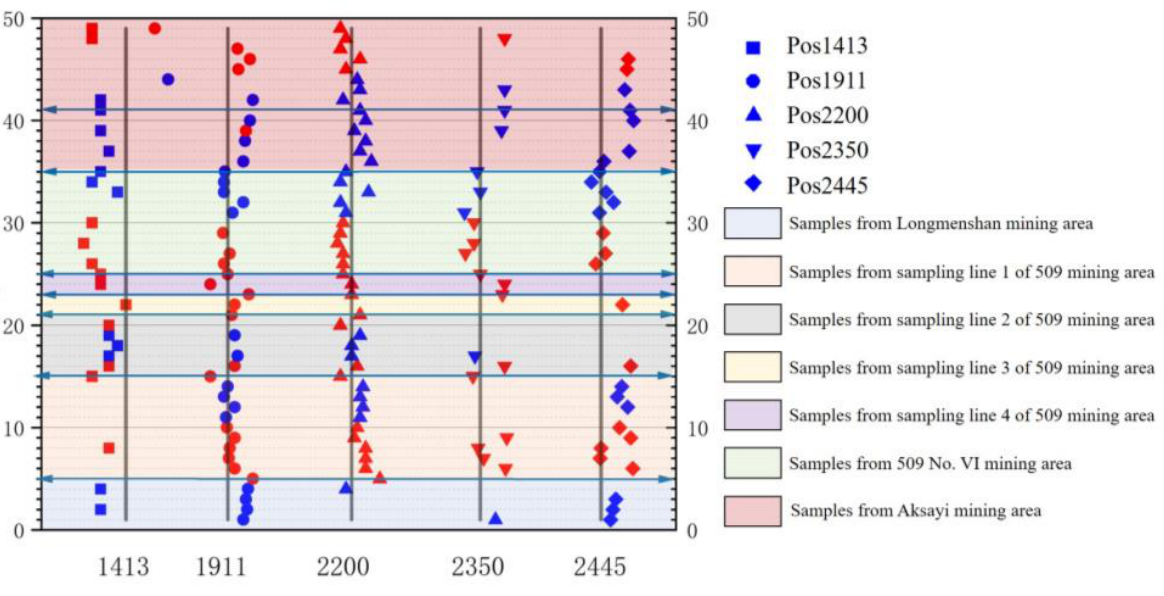
Figure 7. Characteristic band location map. (Red represents Li-rich pegmatite, and blue represents Li-poor pegmatite.).